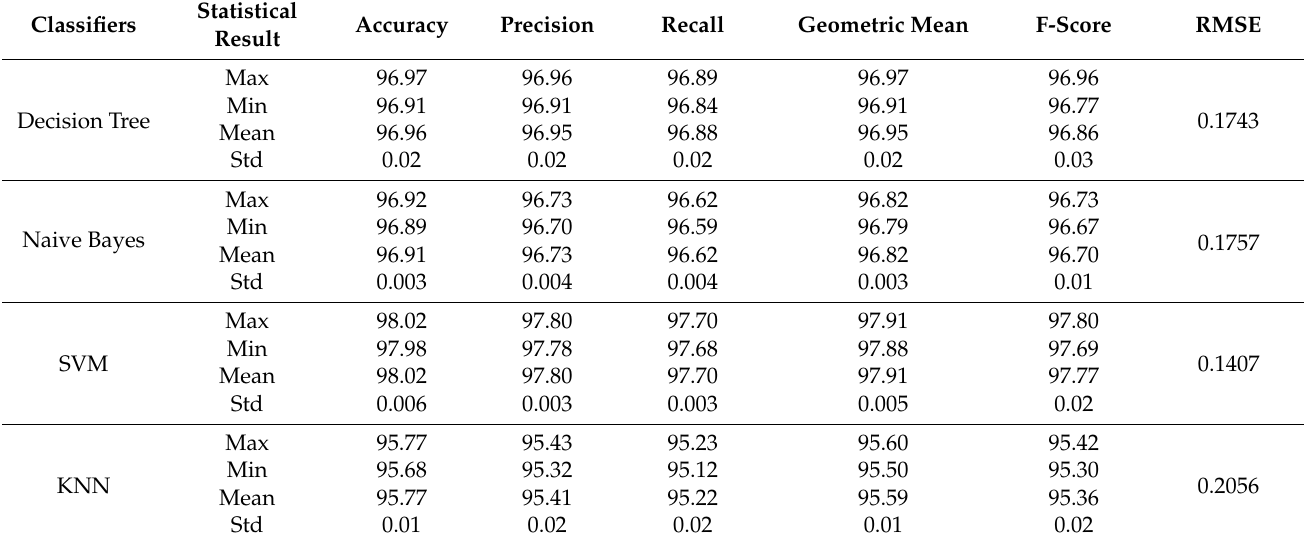
Table 6. Accuracy, precision, recall, geometric mean, F-score and RMSE results after 100 iterations.